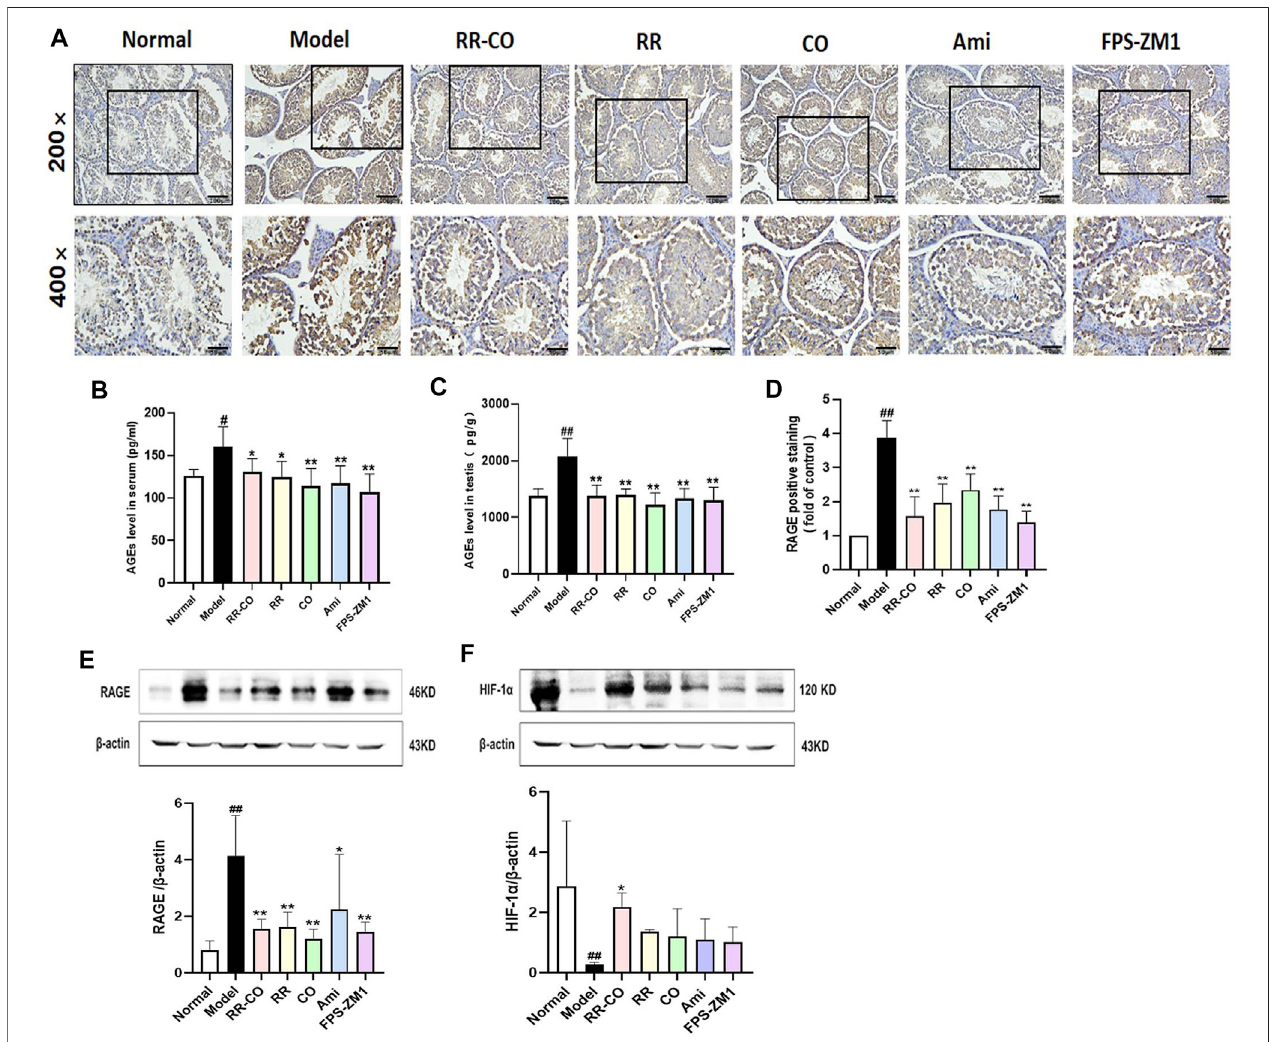
FIGURE5| EffectsofRR-COontheAGEs/RAGE/HIF-1 α axis (A) TheexpressionofRAGEwasdetectedbyImmunohistochemistry(200 × and400 × magni fi cation) (B) AGEs level in serum detected by ELISA kit (C) AGEs level in testis detected by ELISA kit (D) Statistic Chart of RAGE positive staining of Immunohistochemistry analyzedbyImageProPlussoftware (E) WesternblotanalysisofRAGEproteinexpressioninthetestis (F) WesternblotanalysisofHIF-1 α proteinexpressioninthetestis. Signi fi cance: ## p < 0.01 vs. normal group; * p < 0.05, ** p < 0.01 vs. model group.